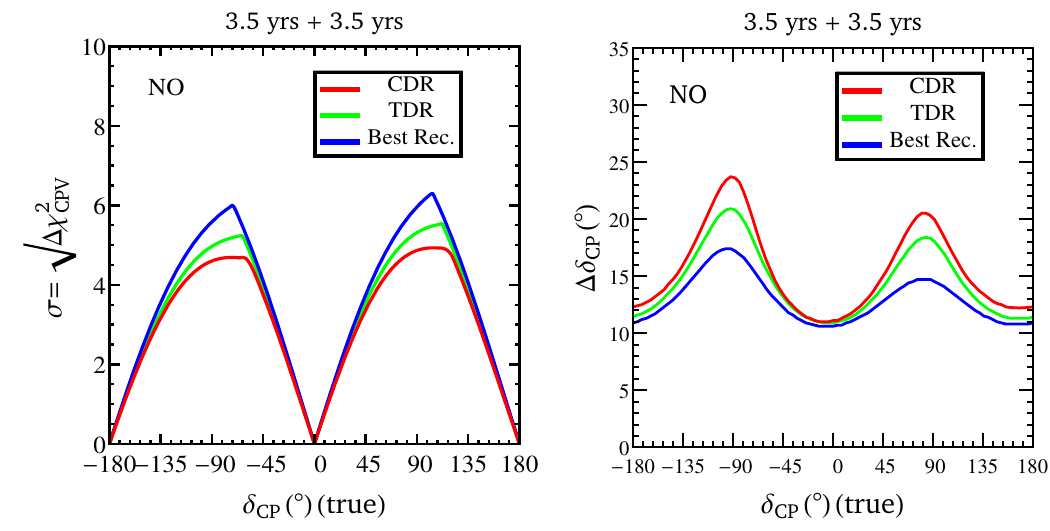
Figure 2 . Left panel : CP violation discovery ( δ CP ( test ) 6 = 0 , ± π ) potential of DUNE with different assumptions on the DUNE energy resolution. Right Panel : 1 σ ( ∆ χ 2 = 1 ) uncertainties on the true value of δ CP determined by DUNE. Red, green and blue curves represent the CDR, TDR and Best Reconstruction setup respectively. We have assumed normal ordering (NO) in the analysis for both